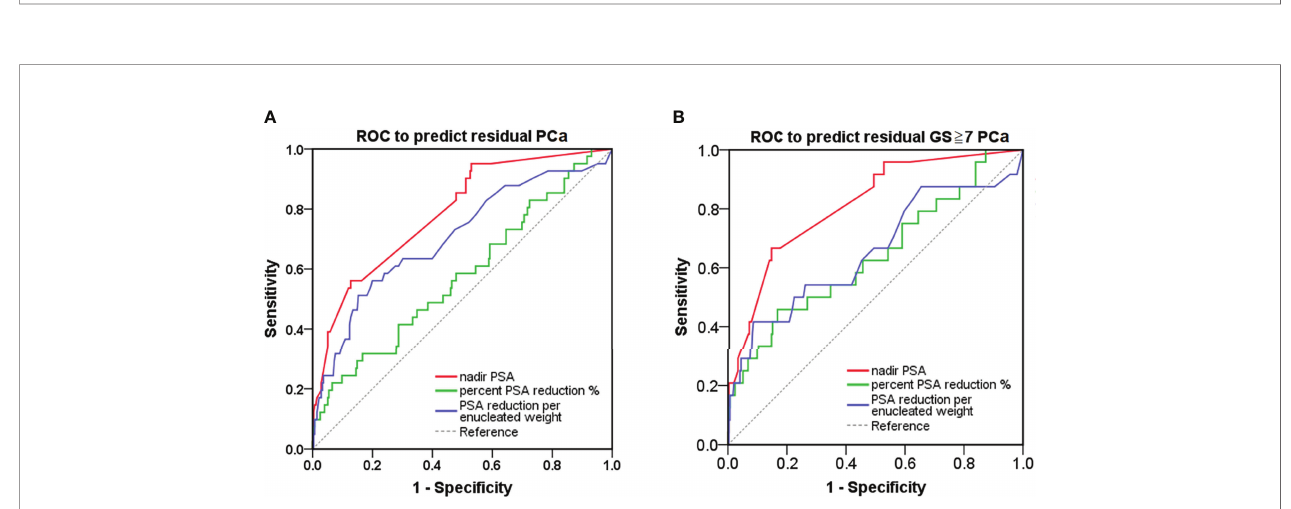
FIGURE 3 | ROC curve analysis for detection of PCa in the remaining prostate after transurethral prostate enucleation. ROC curve analysis of postoperative PSA parameters to predict (A) residual PCa or (B) residual PCa with GS ≥ 7 in the remaining prostate after transurethral enucleation of the prostate. GS, Gleason score; PSA, prostate-speci fi c antigen; PCa, prostate cancer; ROC, receiver operating